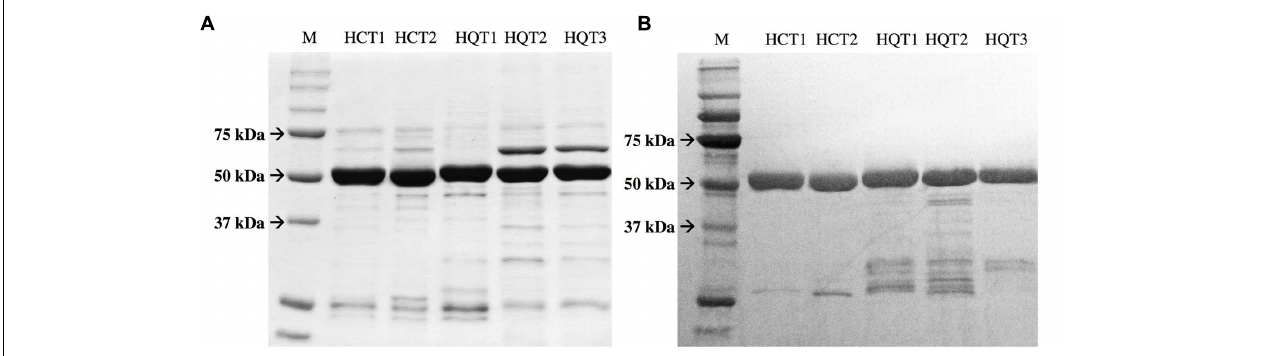
FIGURE 6 | Expression and purification of recombinant HCT and HQT proteins. (A) SDS-PAGE separation of recombinant HCT and HQT. The gel was stained with Coomassie blue. (B) Immunoblot analysis confirming the expression of the recombinant proteins. The proteins were detected with anti-His antibody. M: Markers.